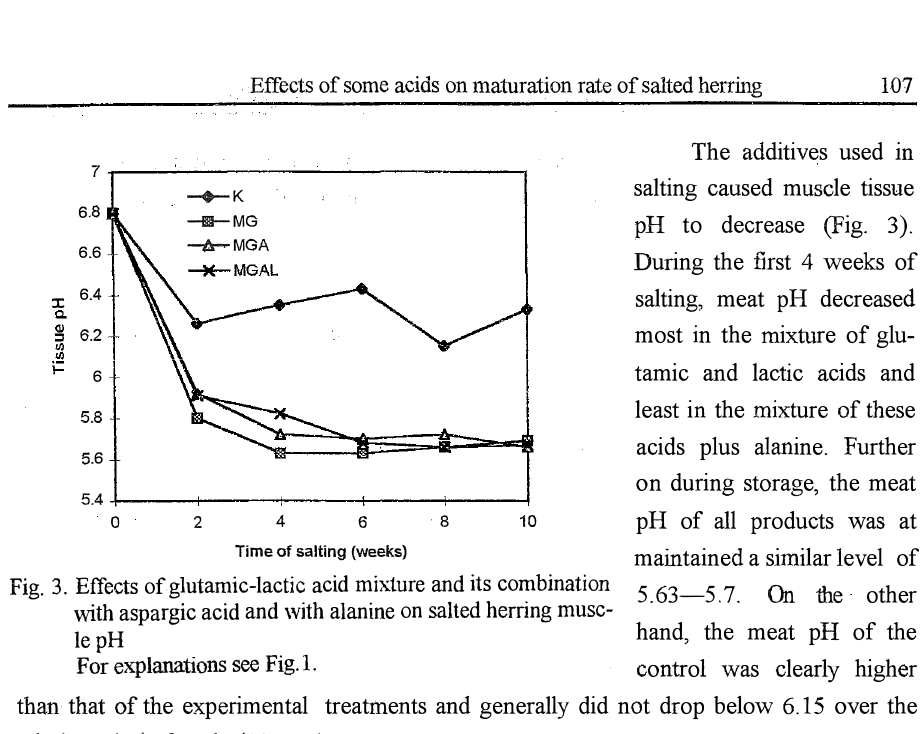
Fig. 3. Effects ofglutarnic-lactic acid mixture and its combination 5. 63_ 5. 7_ On the other wi t h as pa rgi c ac id a n d wi th a la ni ne o n s a l t e d her ring m us c- le pH hand, the meat pH of the For explanations see Fig. L control was clearly higher than that of the experimental treatments and generally did not drop below 6.15 over the whole period of study (I O